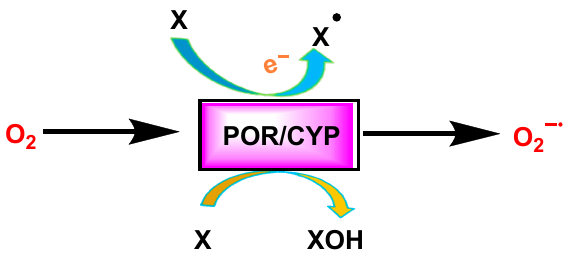
Figure 14. The enzymes cytochrome P450 (CYP)/cytochrome P450 reductase POR, convert molecular oxygen to superoxide either as a main product or as a by-product during oxidation of a variety of compounds X.